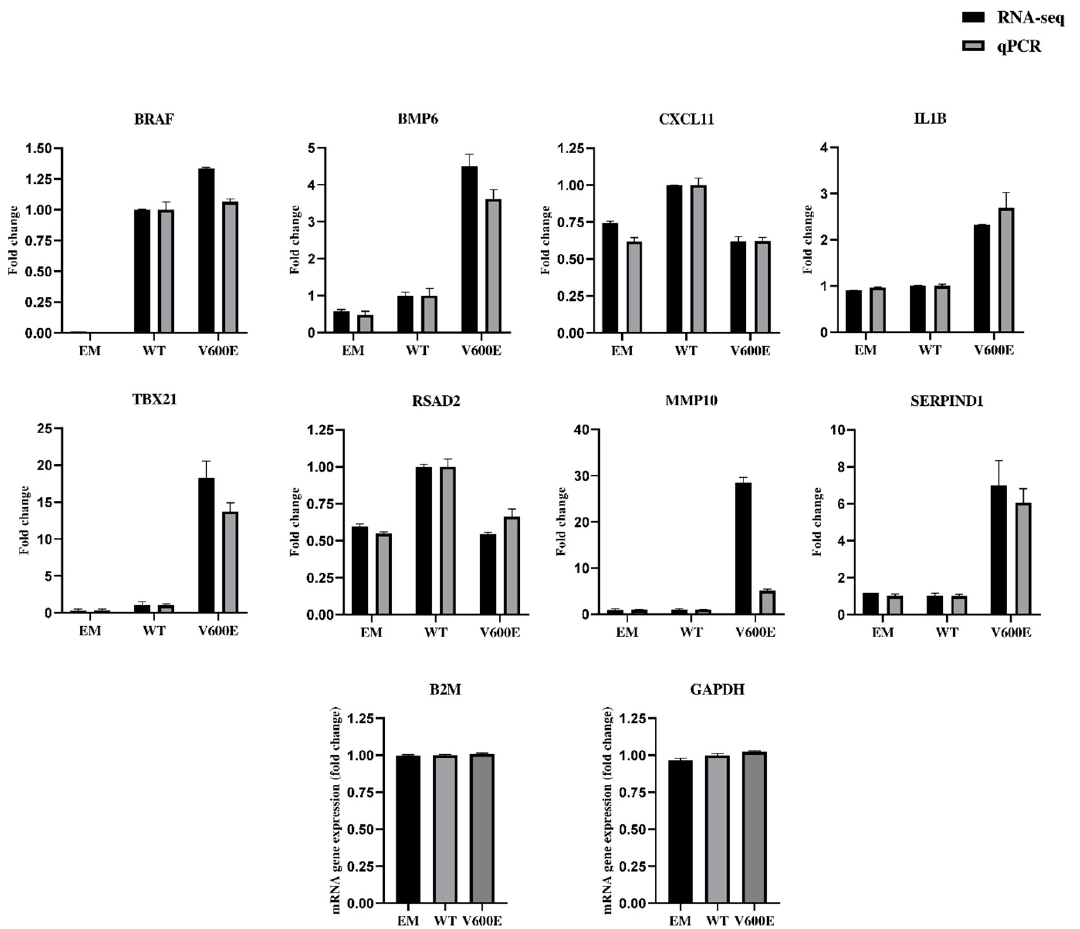
Figure 8. Validation of RNA-seq data by quantitative RT-qPCR (qPCR). The analysis was performed for 8 differentially expressed genes. Black bars represent results obtained from RNA-seq and gray bars indicate qPCR data. B2M was applied for the normalization of gene expression. All data are mean (±SEM), n = 2.